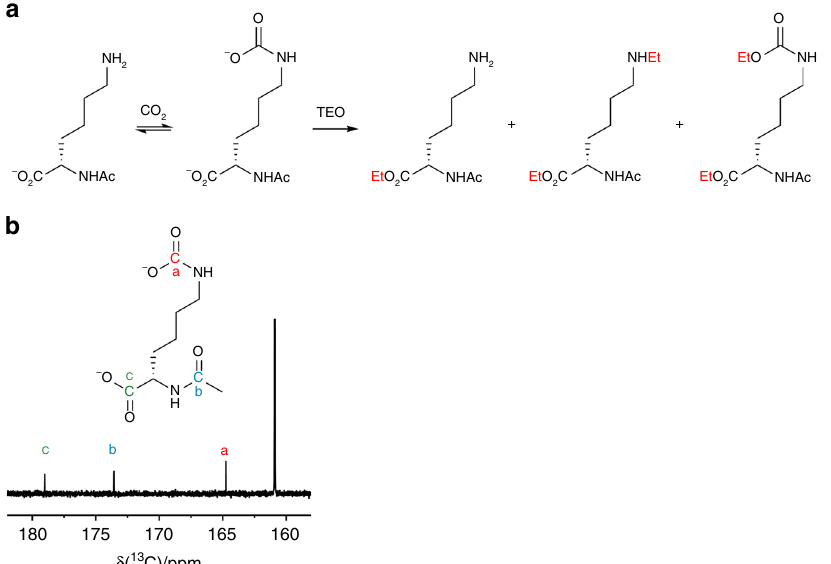
Fig. 2 Carbamate trapping on the ε -NH 2 group of α - N -acetyl-lysine. a N -acetyl-lysine-carbamate formation and trapping ( O -ethylation) by TEO. b 13 C-NMR spectrum demonstrating the formation of a carbamate on N -acetyl-lysine by the appearance of a peak at 164